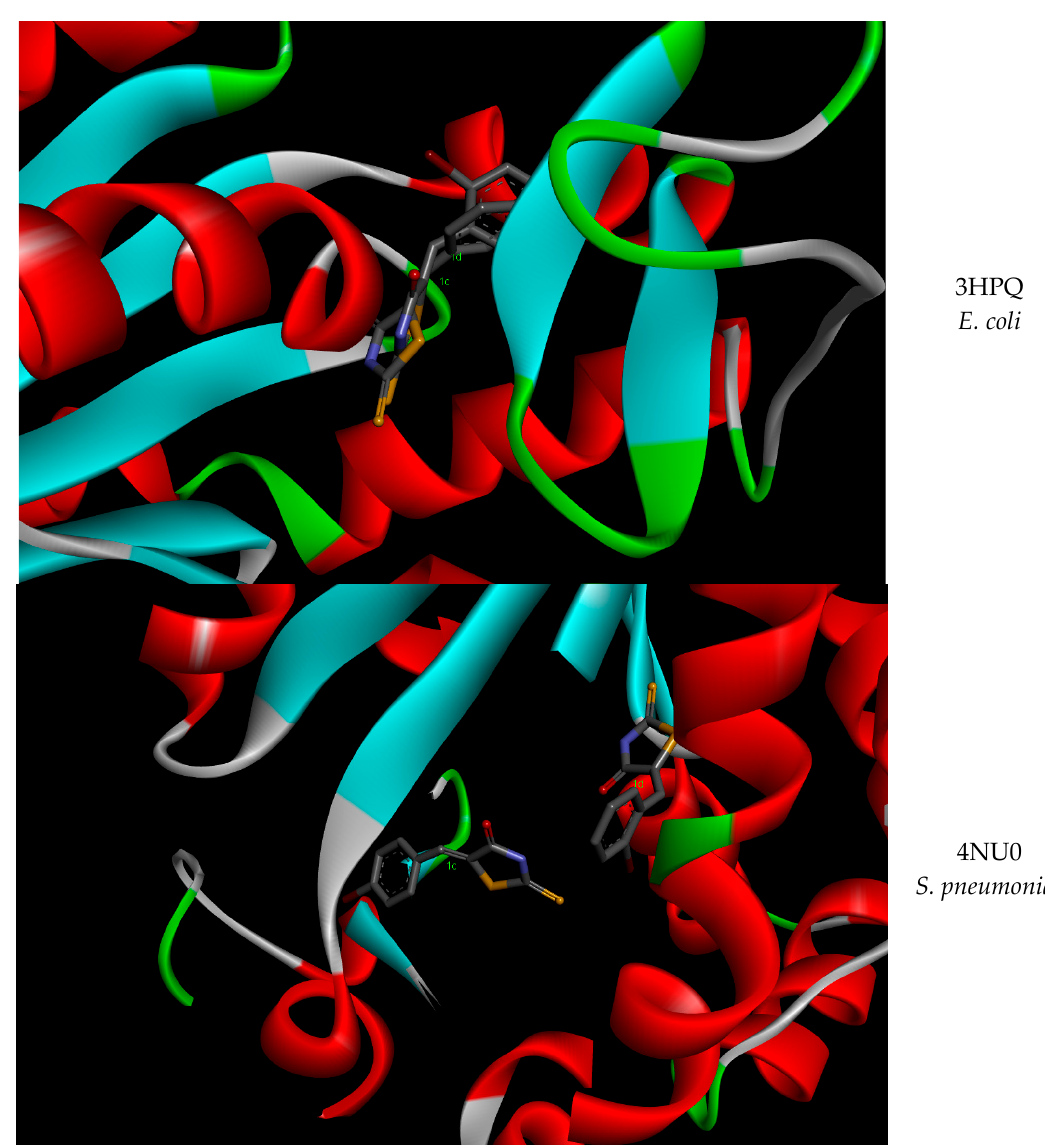
Figure 1. The interactions of the 1c and 1d derivatives with E. coli and S. pneumoniae AKs.